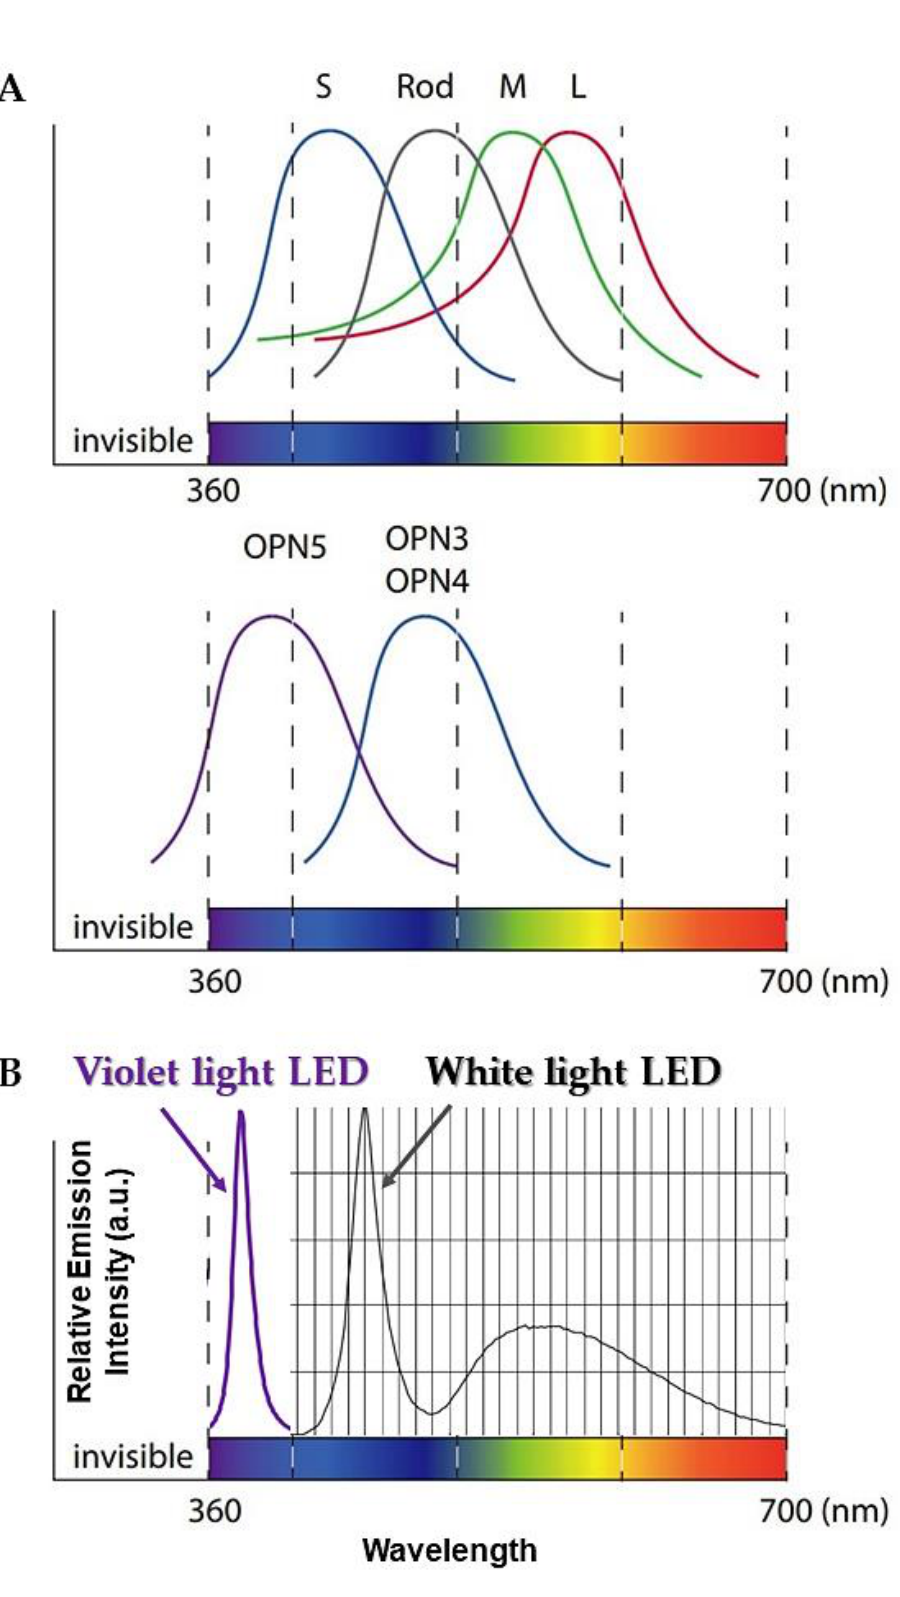
Figure 1. A diagram showing the relationships between the emission spectrum of the LEDs (VL and WL) and the absorption spectrum of the opsins (OPN5, OPN3, and OPN4). ( A ) shows the biological absorption spectrum of opsins; ( B ) represents the emission wavelength of the VL-LED and WL-LED. As shown in Figure 1, the emission wavelength of the VL-LED and the absorption spectrum of OPN5 correspond to each other. VL: violet light; WL: white light; OPN: opsin; S: short-wavelength cone; M: middle-wavelength cone; L: long-wavelength cone.